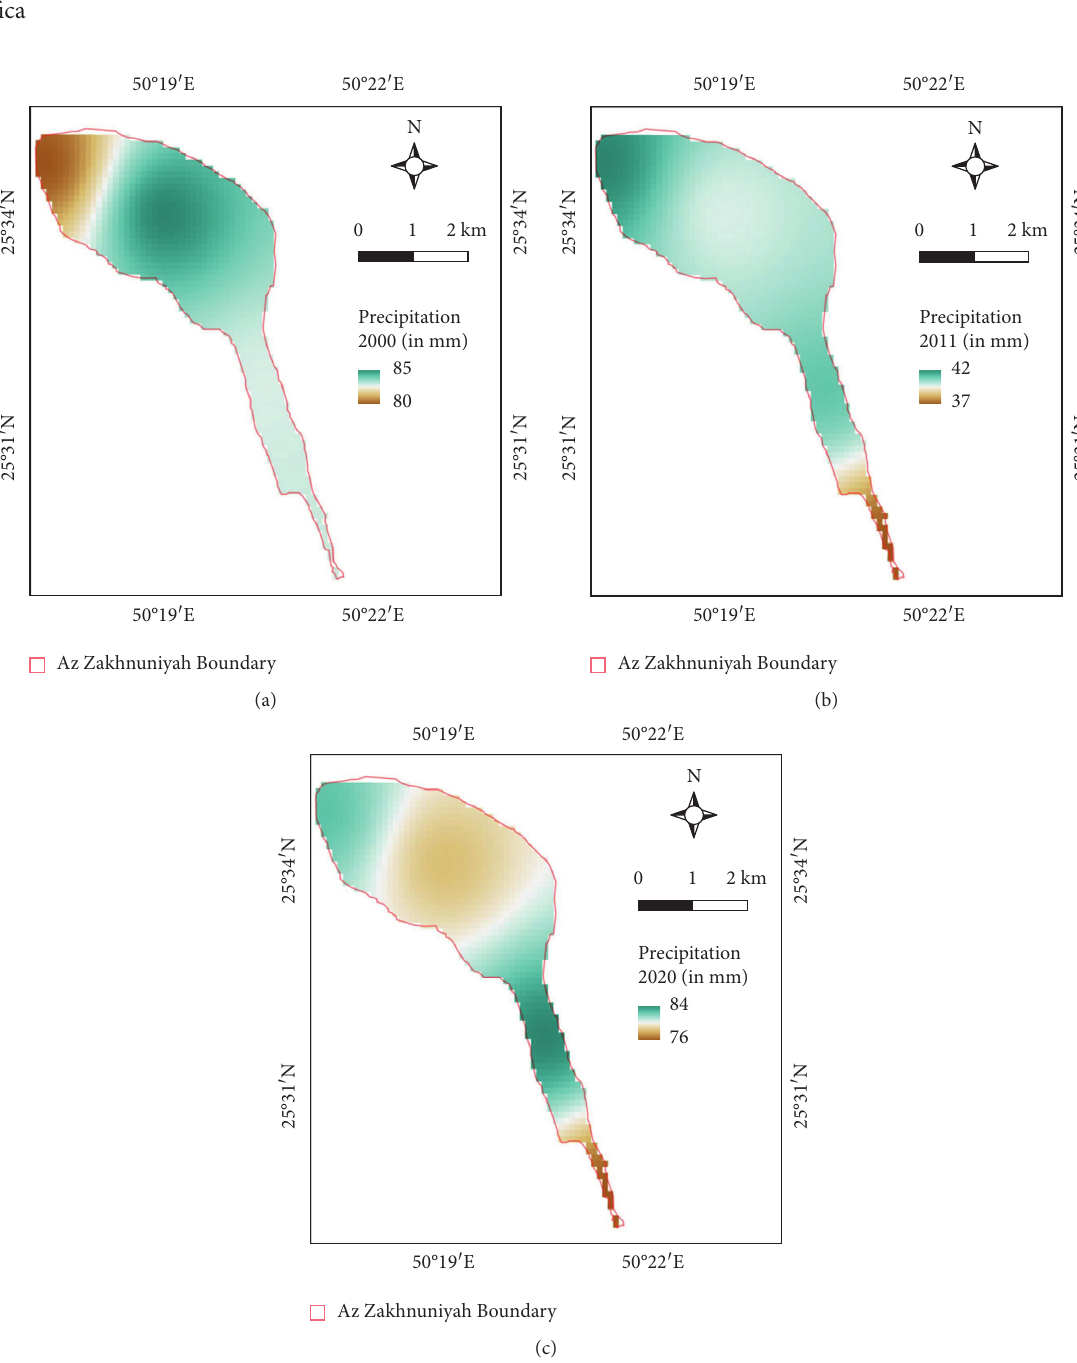
Figure 14: Precipitation map (in mm) of study area for (a) 2000, (b) 2011, and (c)